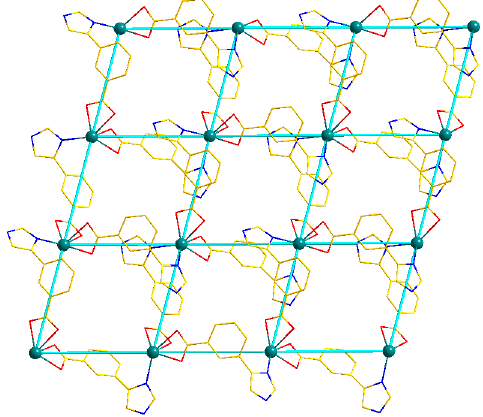
Figure 7. The representation of 6 3 - hcb framework of 2 .